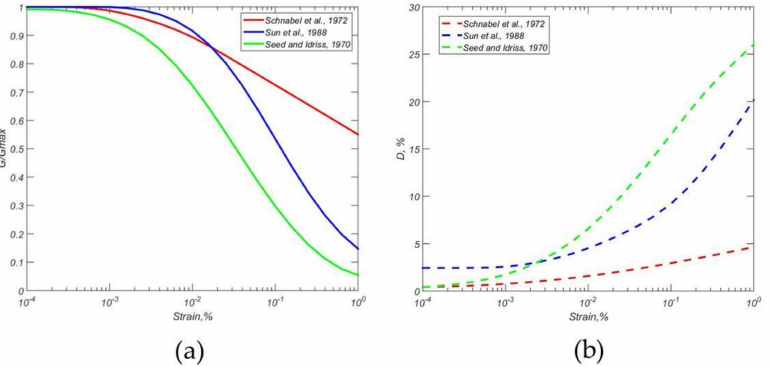
Figure 7. Input soil parameters used in the study: ( a ) shear moduli degradation curves; ( b ) damping ratio